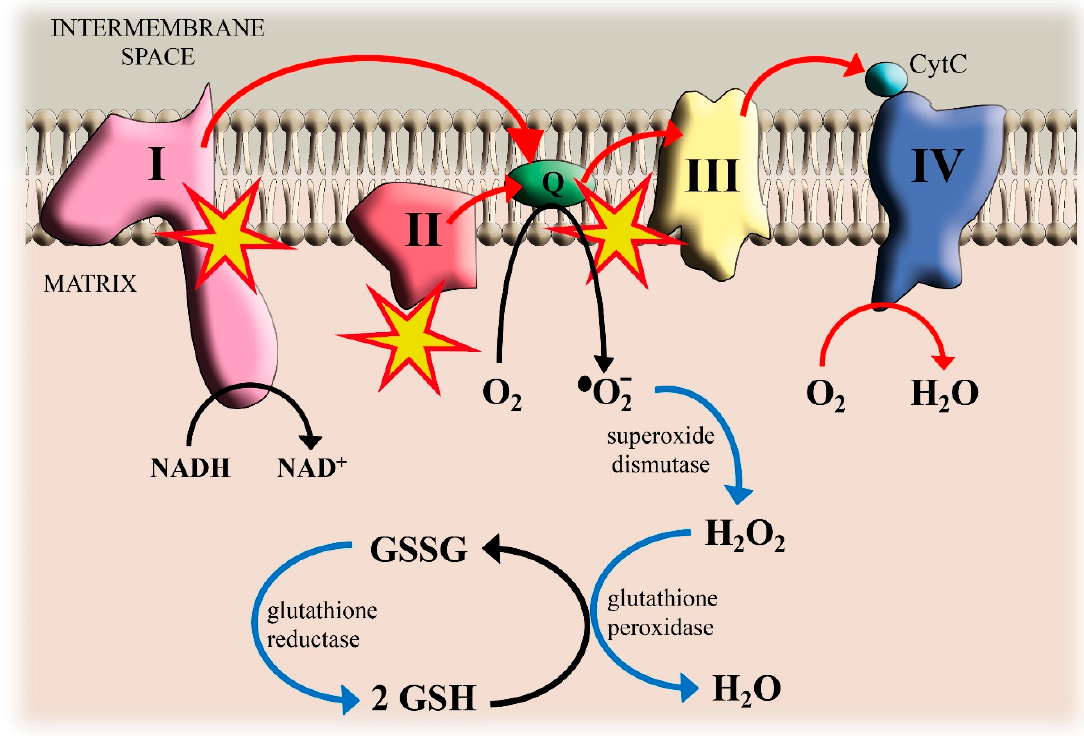
Figure 1. Cadmium (Cd)-induced reactive oxygen species (ROS) formation in mitochondria and antioxidant defenses.